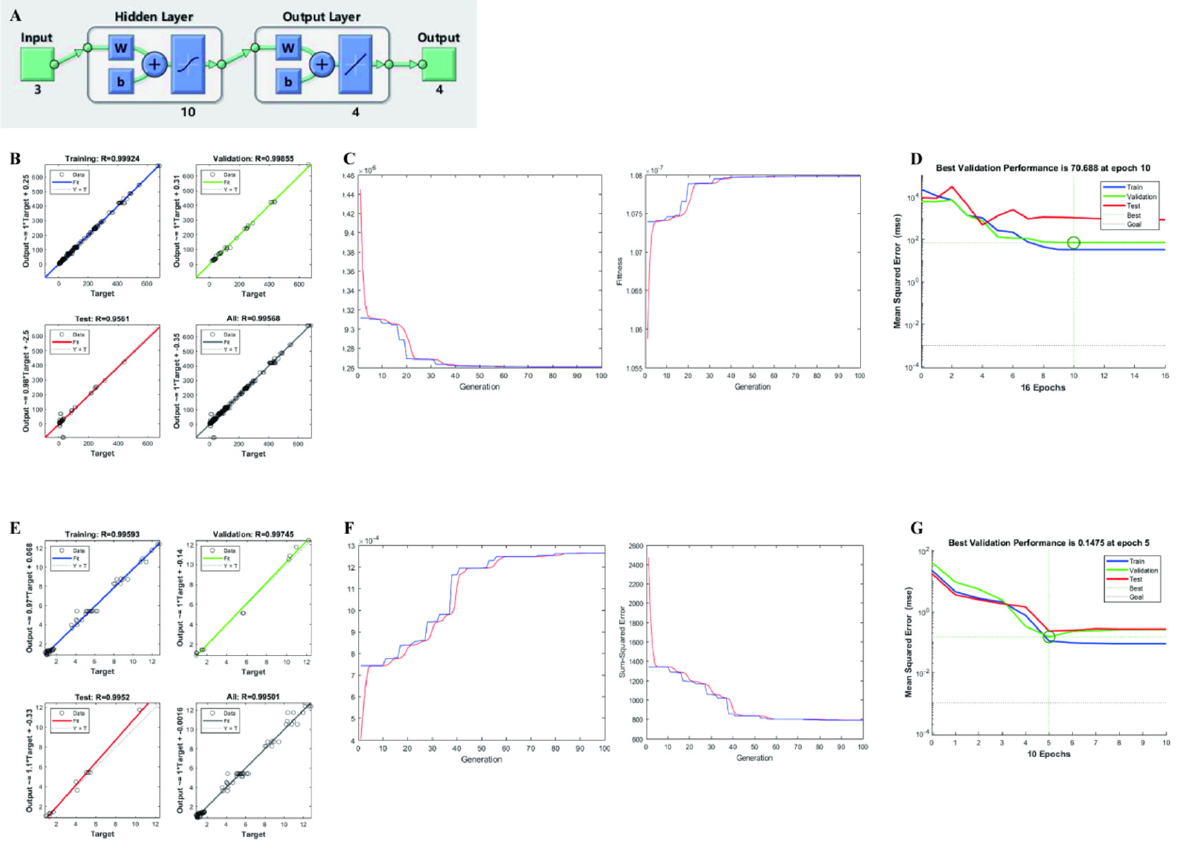
Figure 3. ANN modeling and training. ( A ) ANN architecture topology of both extraction conditions, ( B ) regression of experimental and predicted values in ANN model of Group 1, ( C ) GA algorithm optimization ANN model of Group 1, ( D ) ANN training performance of Group 1, ( E ) regression of experimental and predicted values in ANN model of Group 2, ( F ) GA algorithm optimization ANN model of Group 2, ( G ) ANN training performance of Group 2.